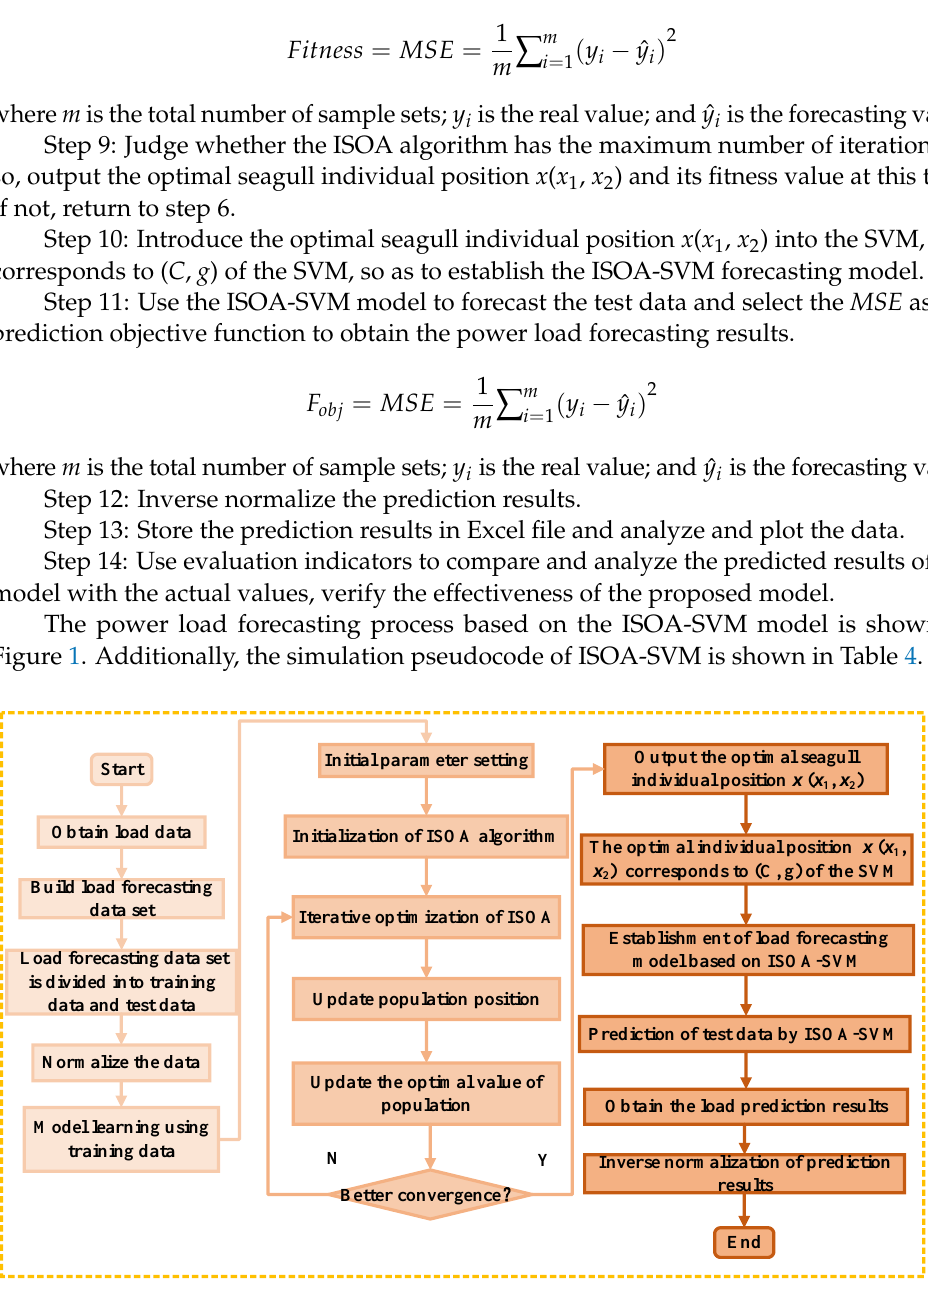
Figure 1. Flow chart of power load forecasting based on the ISOA-SVM model. Table 4. Simulation pseudocode of ISOA-SVM.